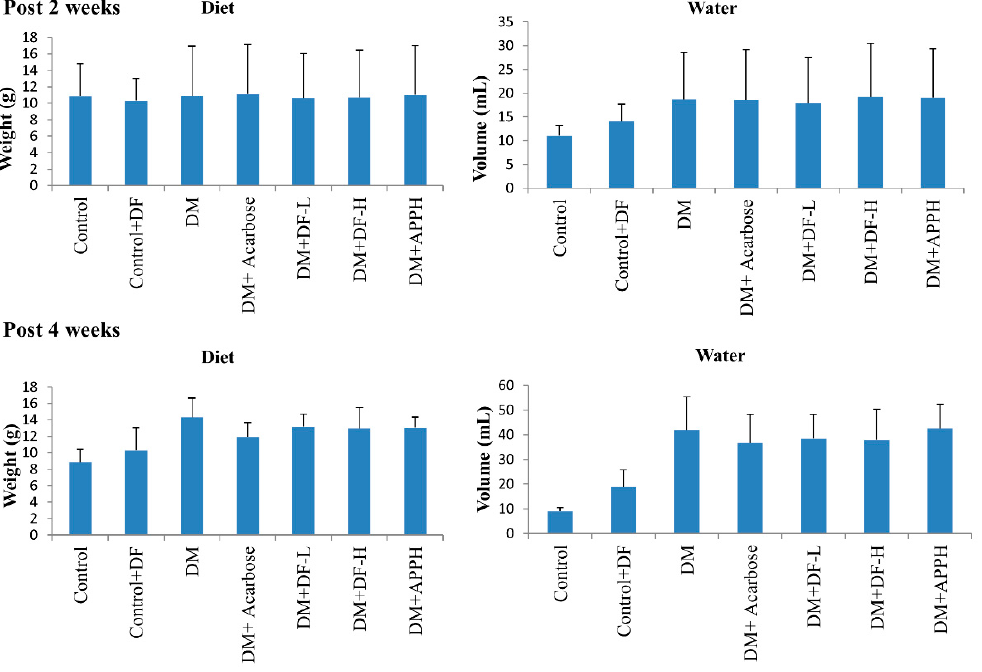
Figure 1. Effect of DIKTNKPVIF (DF) on diet intake. The changes in feed and water intake in non-diabetic control mice (Control), non-diabetic mice treated with 50 mg/kg of DF (Control+DF), STZ-induced diabetes mellitus (DM) mice, DM mice treated with acarbose (DM+Acarbose), DM mice treated with low-dose DF peptide (DM+DF-L), DM mice treated with high-dose DF peptide (DM+DF-H), and DM mice treated with alcalase generated potato protein hydrolysate (APPH) peptide (DM+APPH) after 2 weeks and after 4 weeks of STZ injection. The results represent mean ± SD from 8 mice.